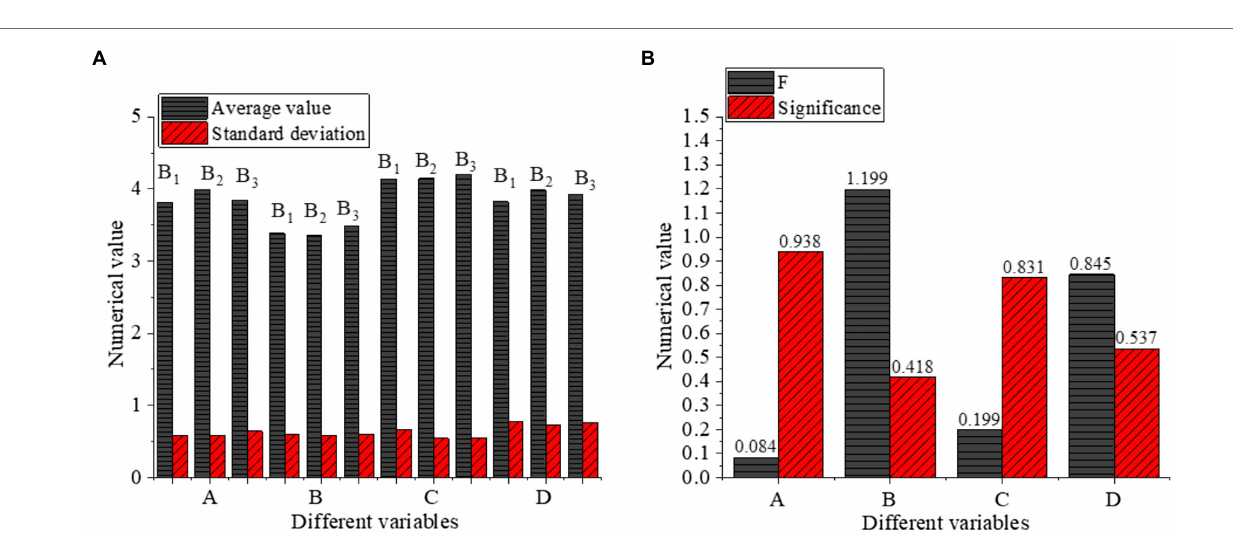
FIGURE 8 | One-way ANOVA of educational background ( A : different variables with Numerical value, B : different variables with Numerical value, B1: Junior college or below B2: Bachelor, B3: Master, A: Cross-cultural competency, B: Cross-cultural adaptation, C: Entrepreneurial intention, D: Psychological adaptation of venture